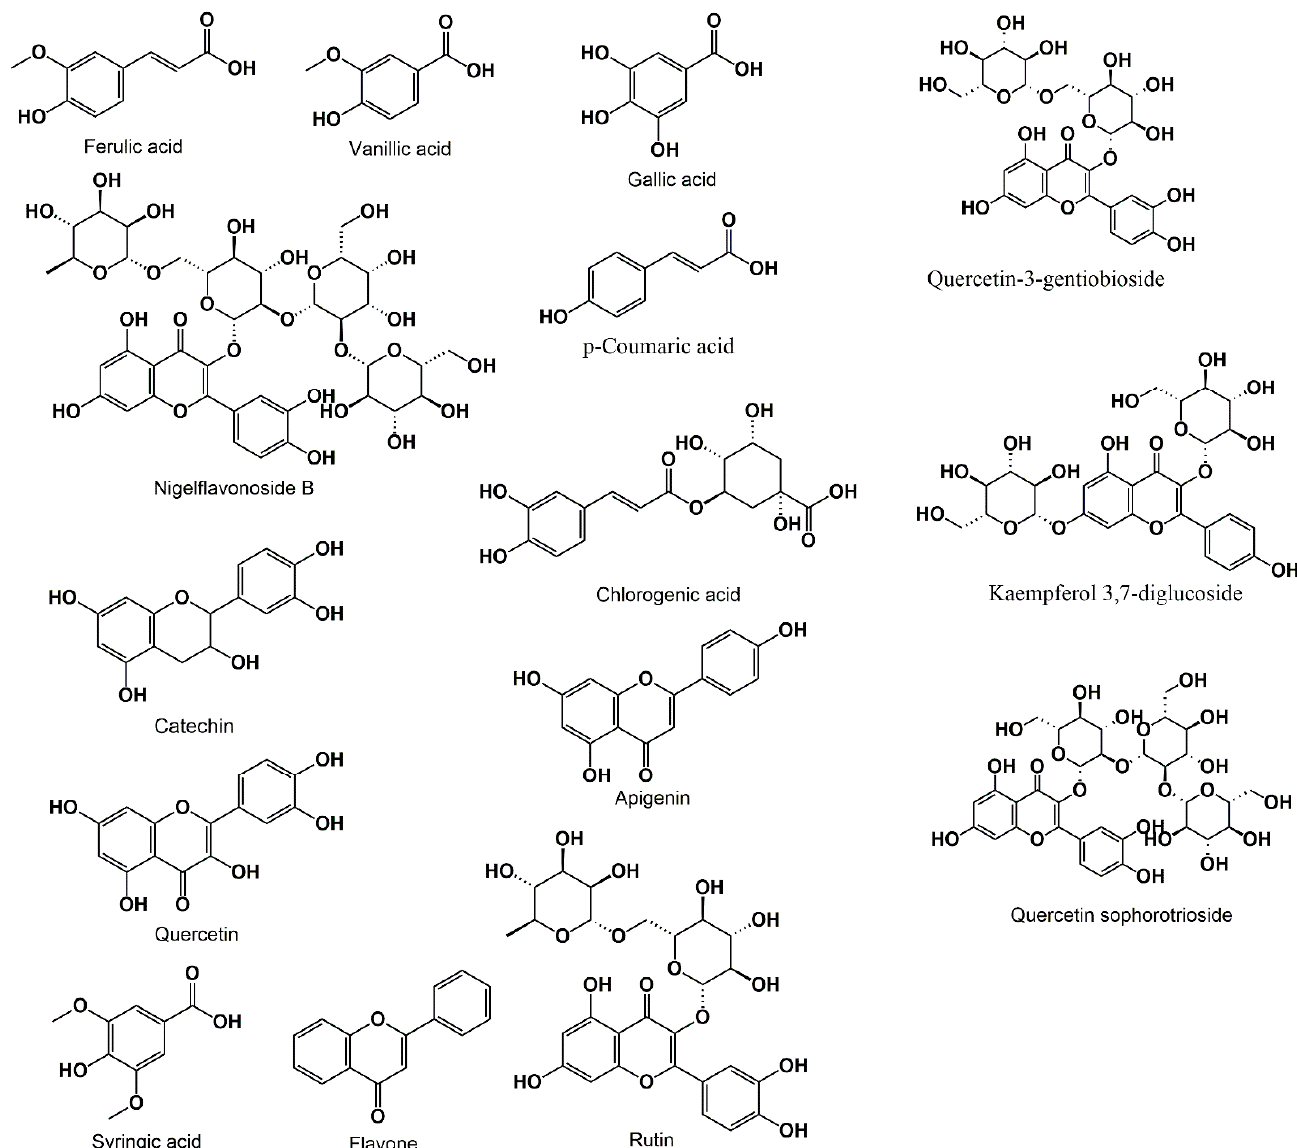
Figure 2. Phenolic compounds present in Nigella sativa